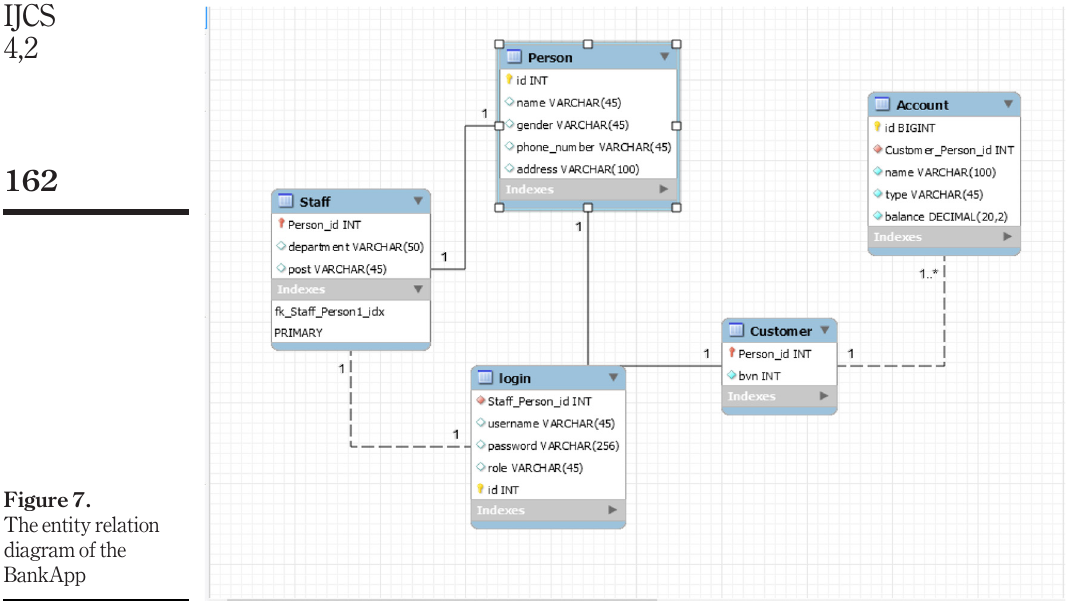
Figure 7. The entity relation diagram of the